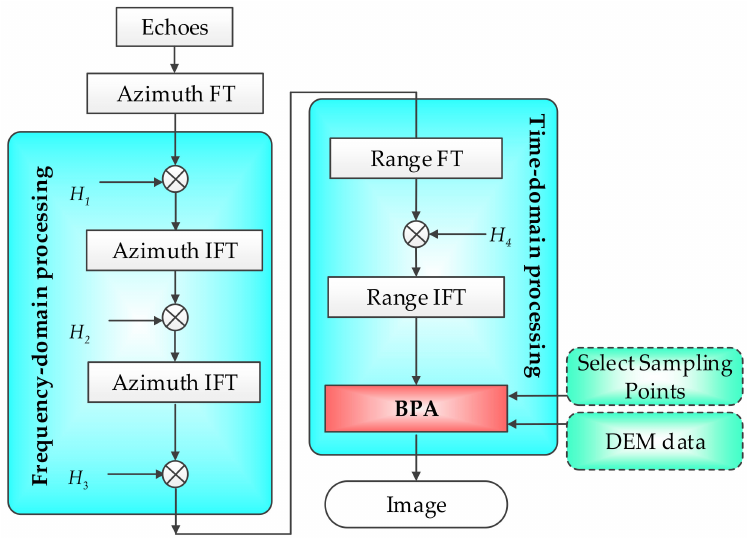
Figure 6. The flowchart of the EBP algorithm. In this flowchart, frequency-domain processing and time-domain processing are